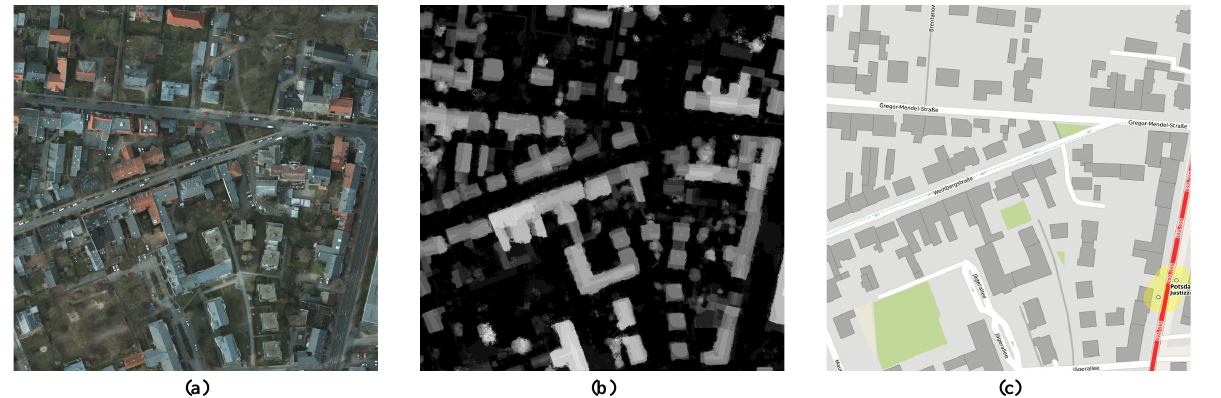
Figure 8. A sample from Potsdam dataset. From left to right, they are the data for ( a ) original high-resolution remote sensing RGB image, ( b ) the normalized DSM image and ( c ) the corresponding OSM